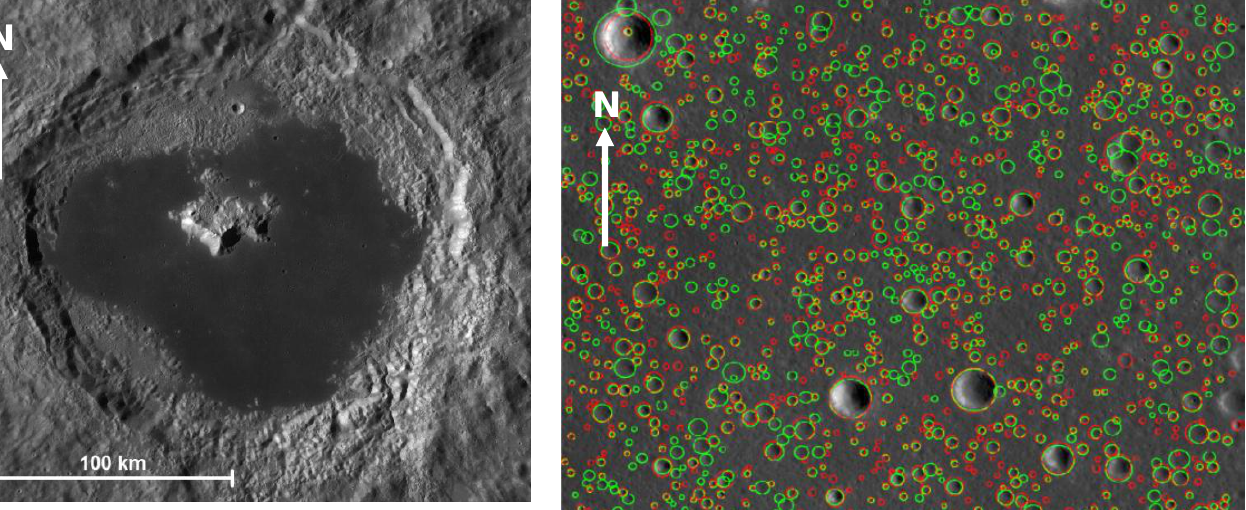
Figure 3. Tsiolkovsky Crater image, extracted from the Lunar Reconaissance Orbiter Wide Angle Camera global mosaic (Speyerer et al., 2011).